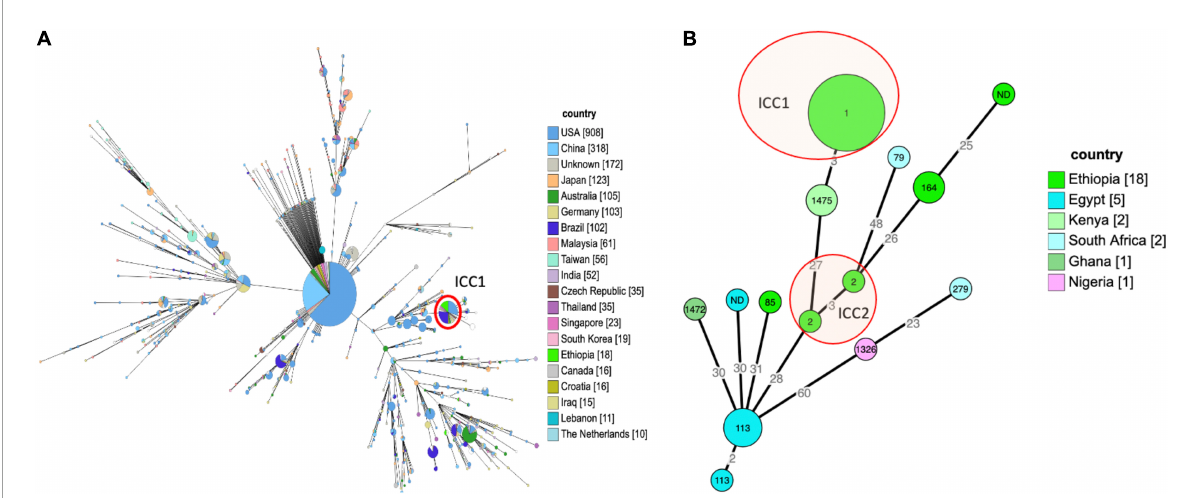
FIGURE1 (A) Epidemiologic relatedness of A. baumannii isolates to the isolates collected from different geographical regions and deposited in the public database (pubmlst https://pubmlst.org/organisms/acinetobacter-baumannii~-- accessed on 26-09-2021), the isolates from this study (bright green) were clustered with the global ICC1 clone marked with red circle. The numbers in the circle show the sequence type of the isolates, the size of the circle is proportional to the number of isolates that belongs to that sequence type, and the color shows the country of origin for the isolates. The minimum spanning tree was constructed for isolates from different country of origin having ≥ 10 isolates recorded in the database. (B) Minimum spanning tree of 29 A. baumannii isolates from Africa, the tree was constructed based on core genome multi-locus sequence typing. There were no previous isolates from Ethiopia in PubMLST, all isolates labeled Ethiopia in the tree are from this study.